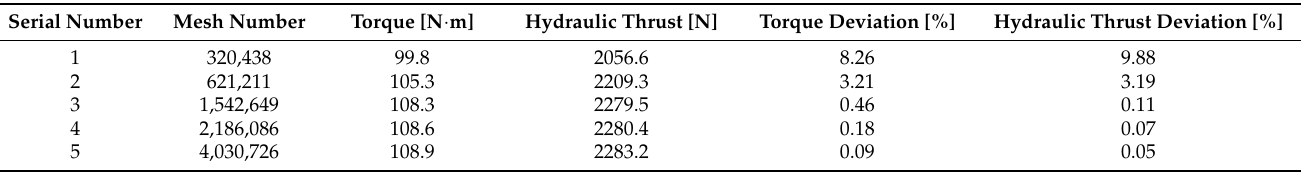
Table 1. Mesh independence verification.